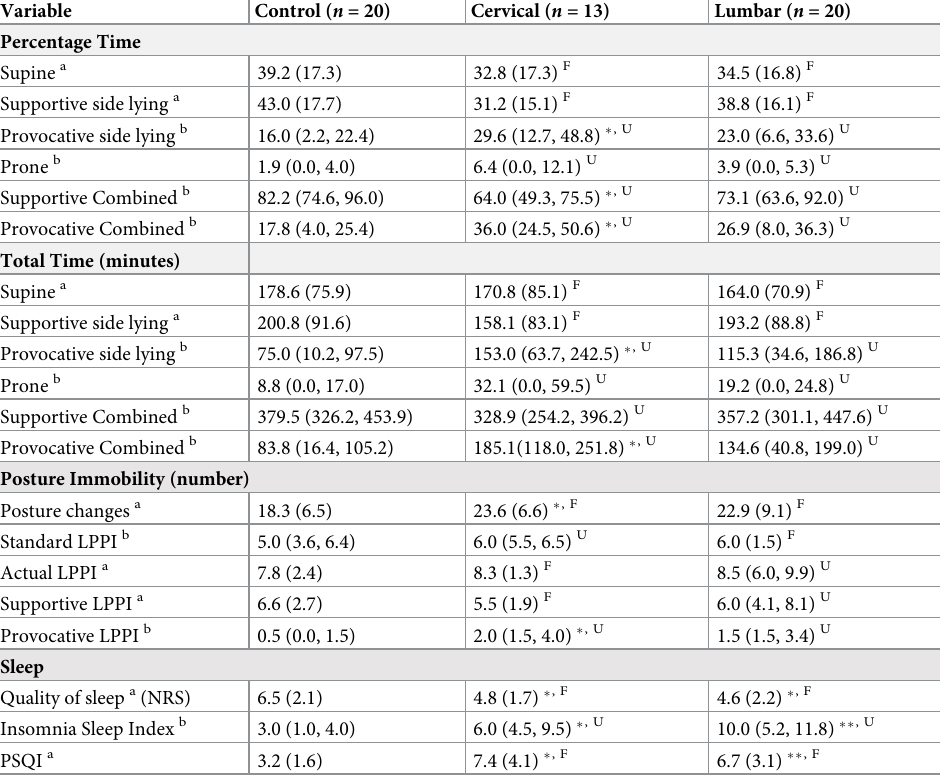
Table 3. Comparisons between the Control and Symptomatic groups in time spent in each posture, expressed as a percentage of the total time in bed (percentage time) or in minutes (total time) and posture